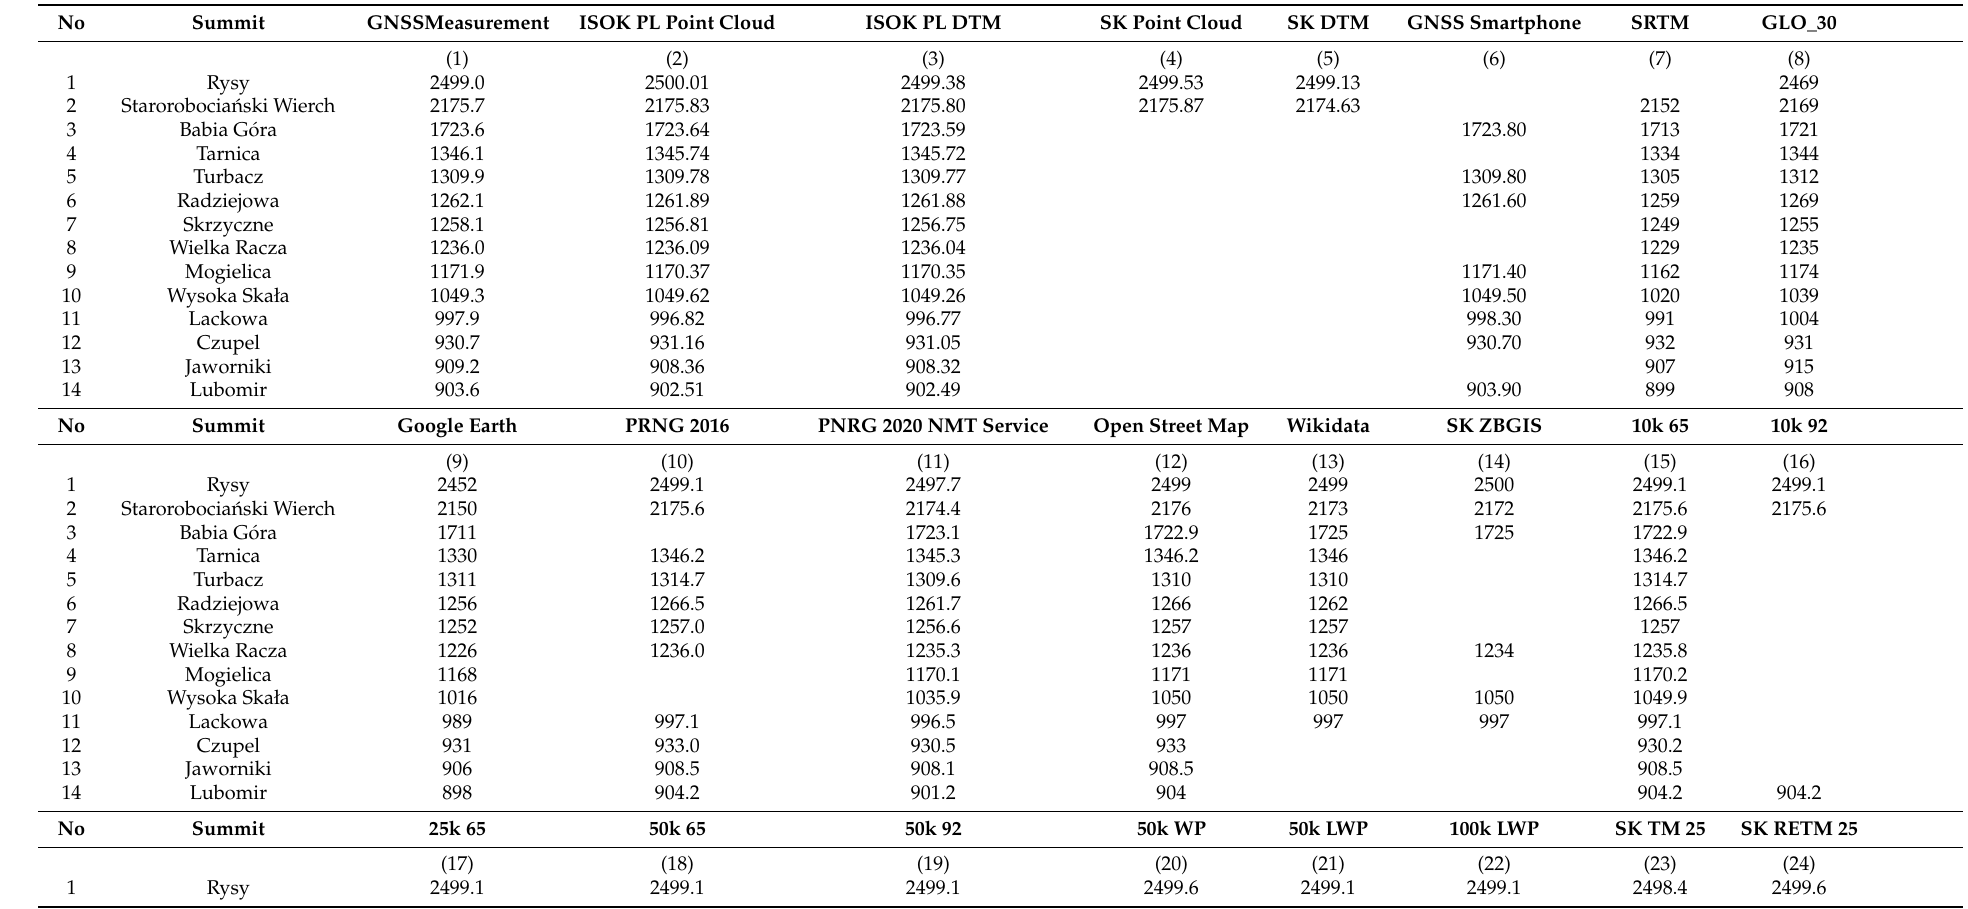
Table A1. The peak heights in each data source. The sources are discussed and described in Section